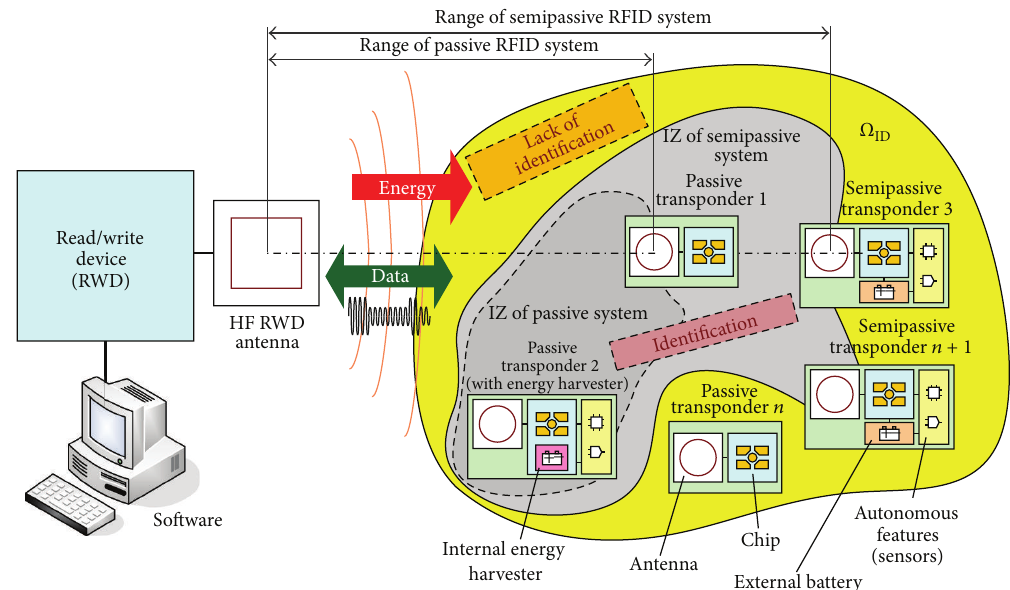
Figure 1: Block diagram of passive and semipassive RFID